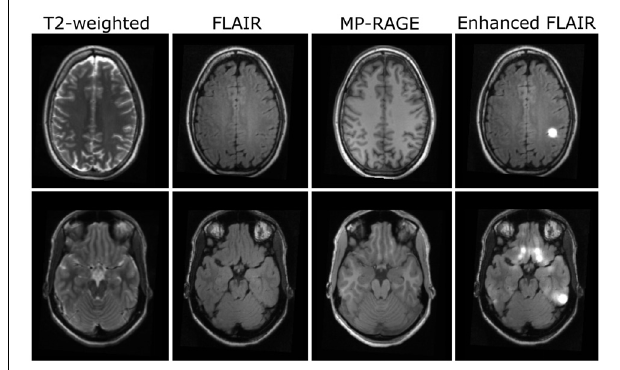
FIGURE 4 | Examples for artifacts in datasets of two healthy subjects (rows). From left to right: T2-weighted, FLAIR-, MP- RAGE-, and enhanced